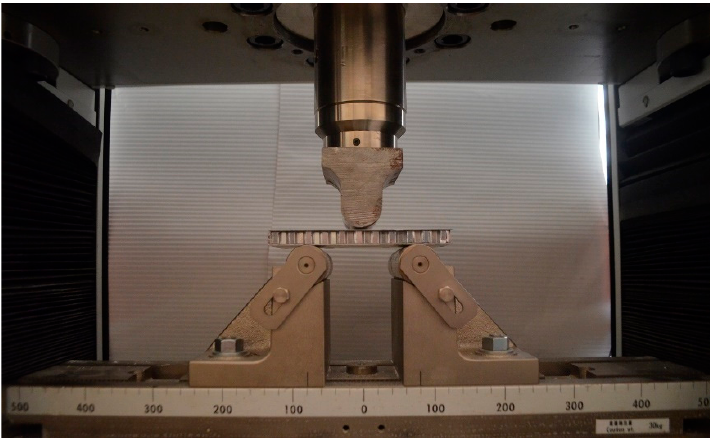
Figure 2. Application of load to specimens during the static test.